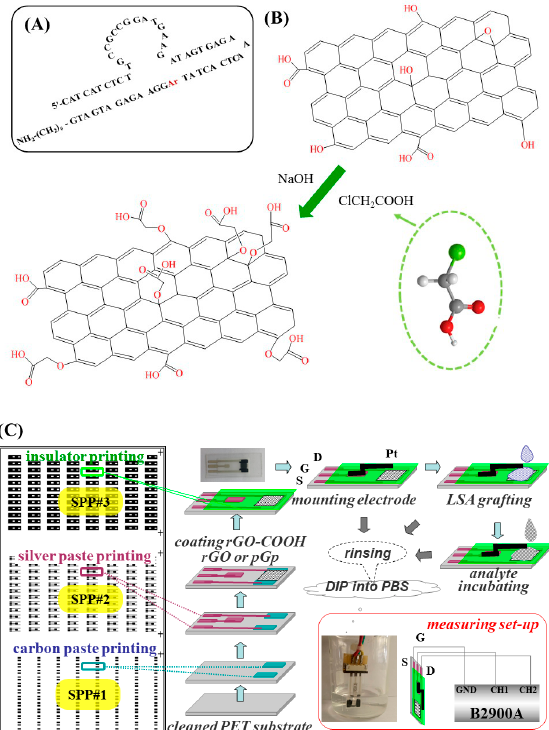
Figure 1. Protocol for the studies of reduced carboxyl-graphene oxide (rGO-COOH) based self-activated graphene field effect transistors (GFETs). ( A ) The nucleotides’ sequence and the molecular configuration of the lead specific aptamer used in this work. ( B ) The sketched principle for preparing GO-COOH. ( C ) A schematic representation for fabricating screen printed GFETs, the measuring set-up and the experimental procedure.